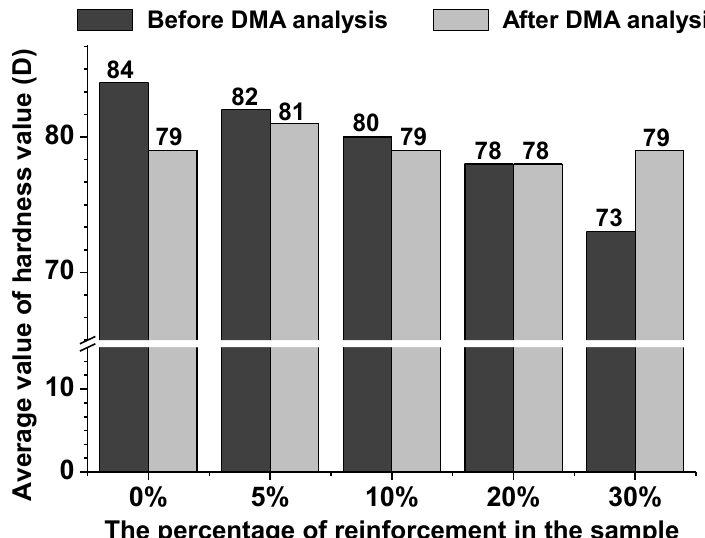
Figure 12. Hardness diagram of the obtained composites. Table 6. Values of hardness test of the synthesized samples. Fibers Content (wt.%)